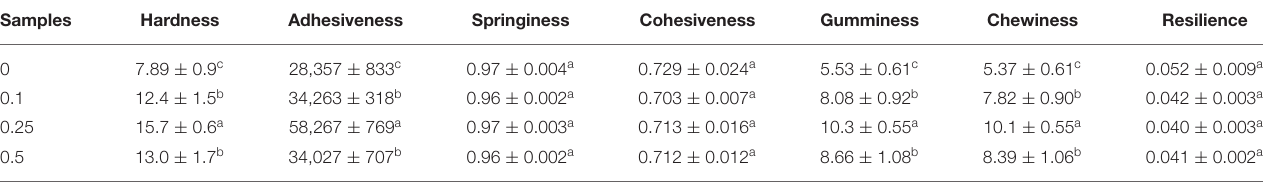
TABLE 1 | Texture properties of yogurt with different concentrations (0, 0.1, 0.25, and 0.5 mg/ml) of procyanidin. Samples